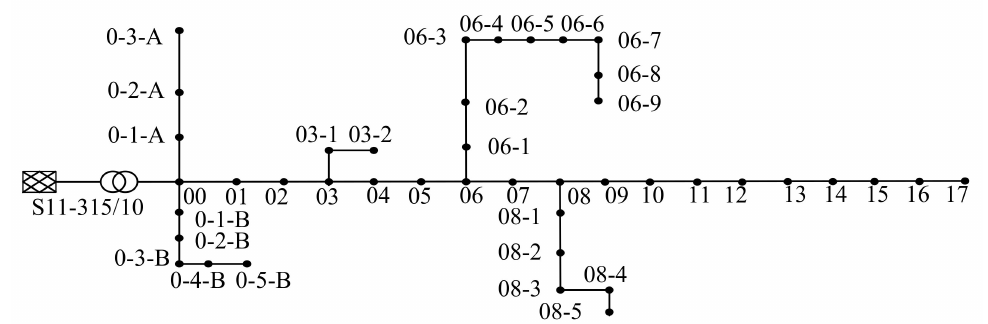
Figure 7. Topology of low voltage platform area.